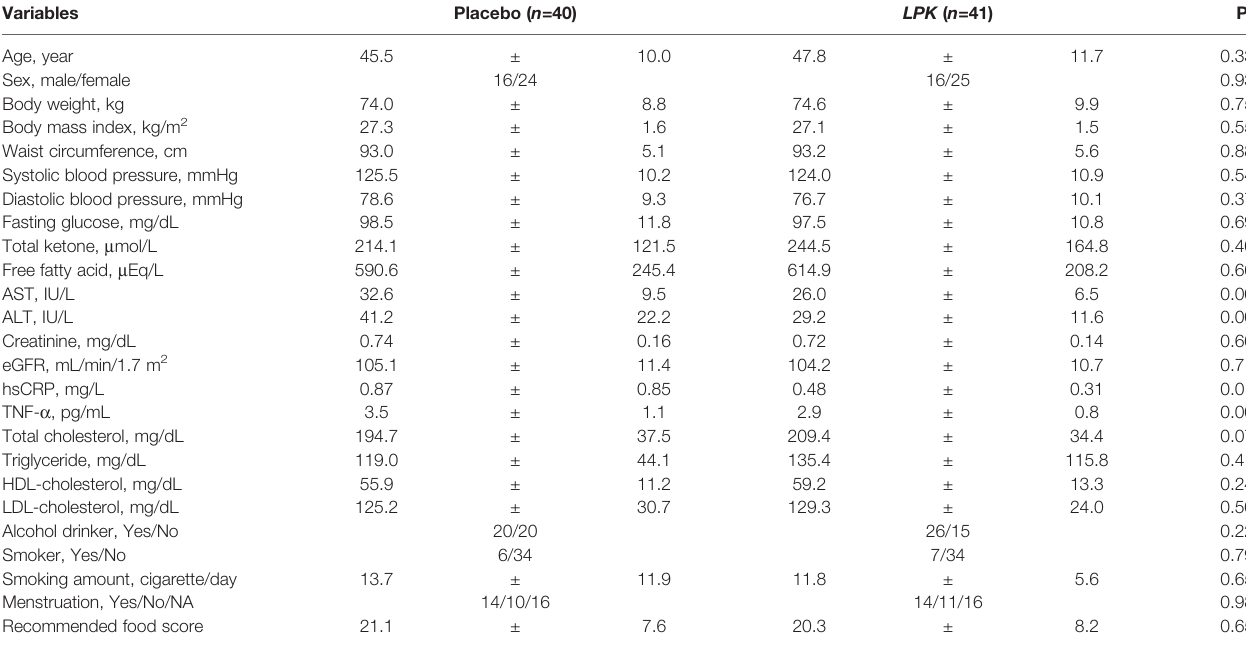
TABLE 1 | Baseline characteristics of study participants.